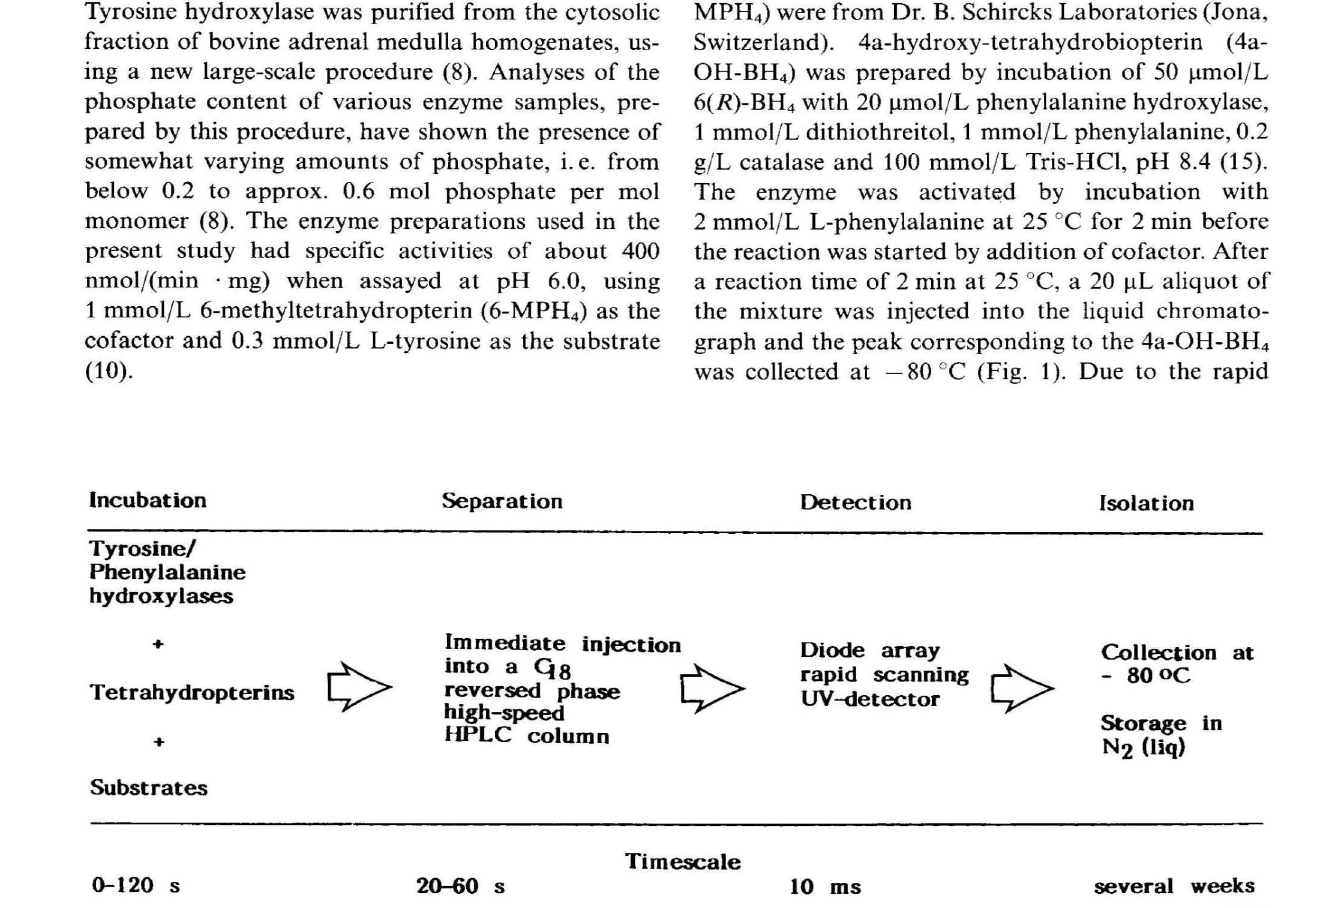
Figure 1. Generation and isolation of tetrahydTOpterin oxidation products. For further details, see the main text. Pteridines ! Vol. 1 ,I 1989 /